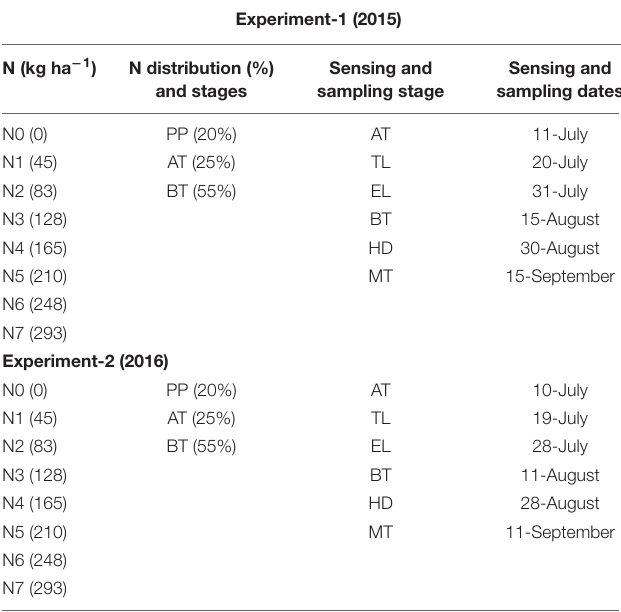
TABLE 1 | Basic information about the two field experiments conducted during 2015 and